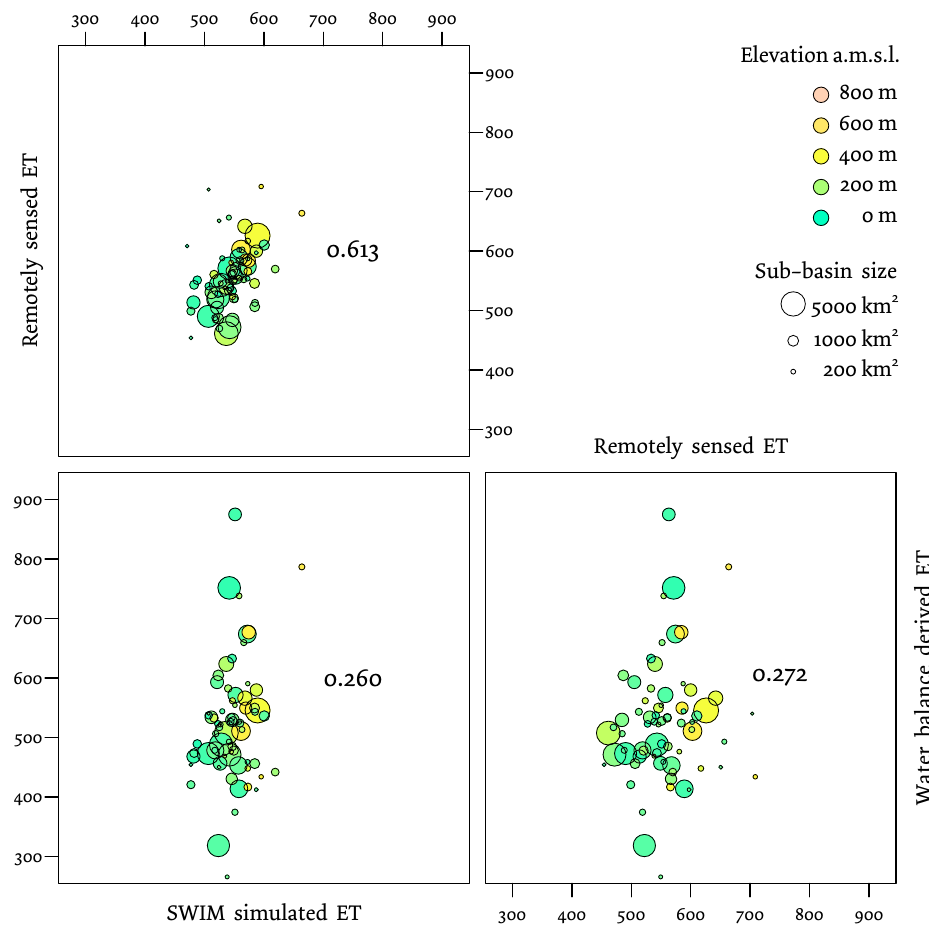
Fig. 14. Correlations between remotely sensed, SWIM simulated, and water balance derived evapotranspiration in mma − 1 for the 72 sub- basins in the German part of the Elbe River basin.